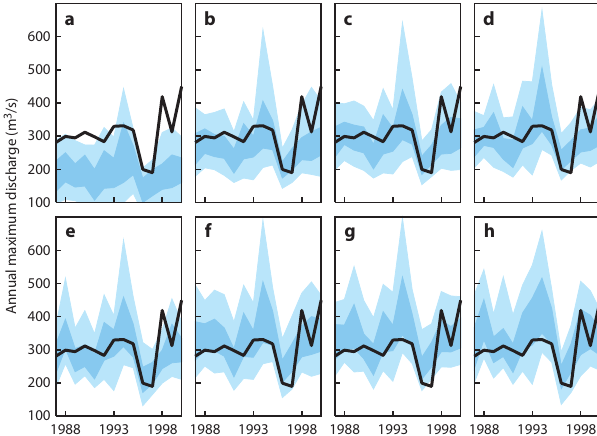
Fig. 7. Annual maximum runoff modelled by the HBV model at the station Montford driven by (a) raw output and with MOS using (b) QM, (c) QM-M, (d) QM-L, (e) DM, (f) DBS, (g) DBS-M and (h) DBS-L. The lighter blue areas show the 5th to 95th percentile, the darker blue show the 25th to 75th percentile. The black line is observed